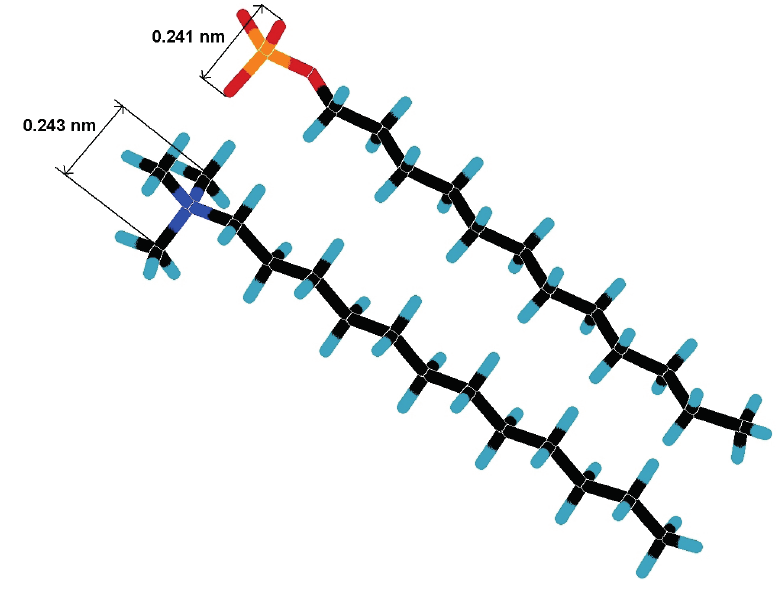
Figure 7: Models of DTAB (bottom) and SDS (top) molecules in straight alkyl chain conformation.